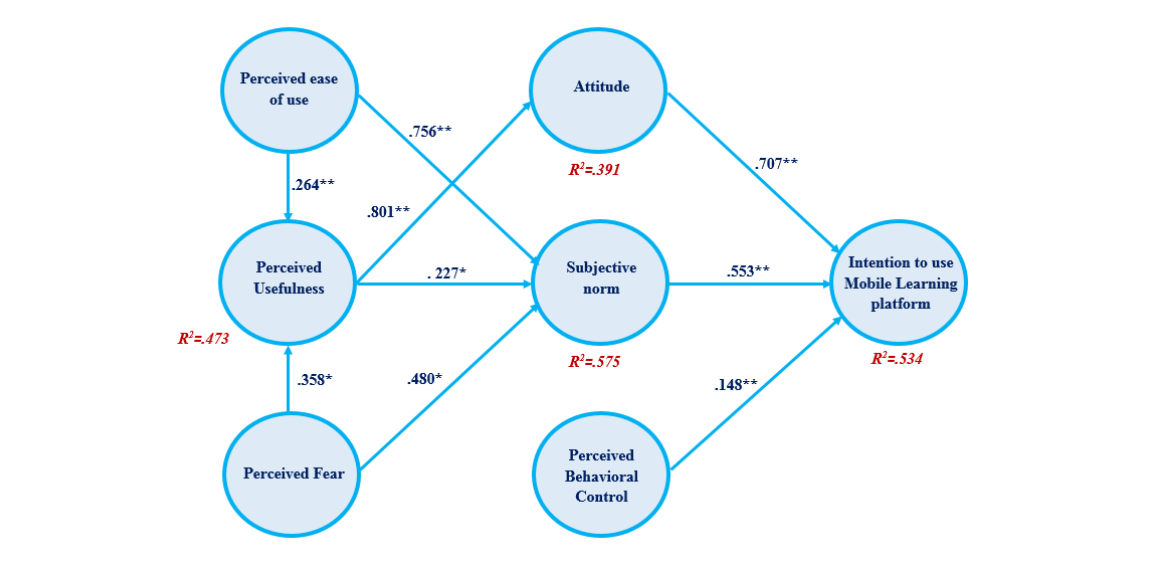
Figure 2. Hypotheses testing results. The R 2 values reported are for perceived usefulness, attitude, the subjective norm, and the intention to use a mobile learning platform. The β values and statistical significance of each path are also reported. *significant at P <.05, **significant at P ≤